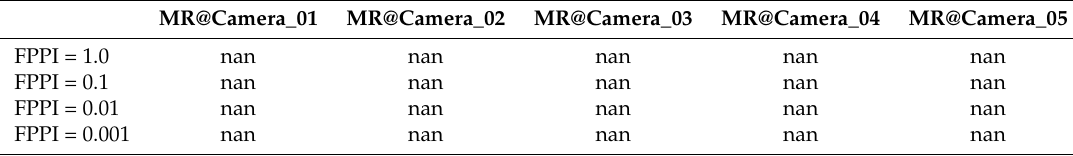
Table 7. Accuracy table @ Cameras_01–05, YOLOv3.